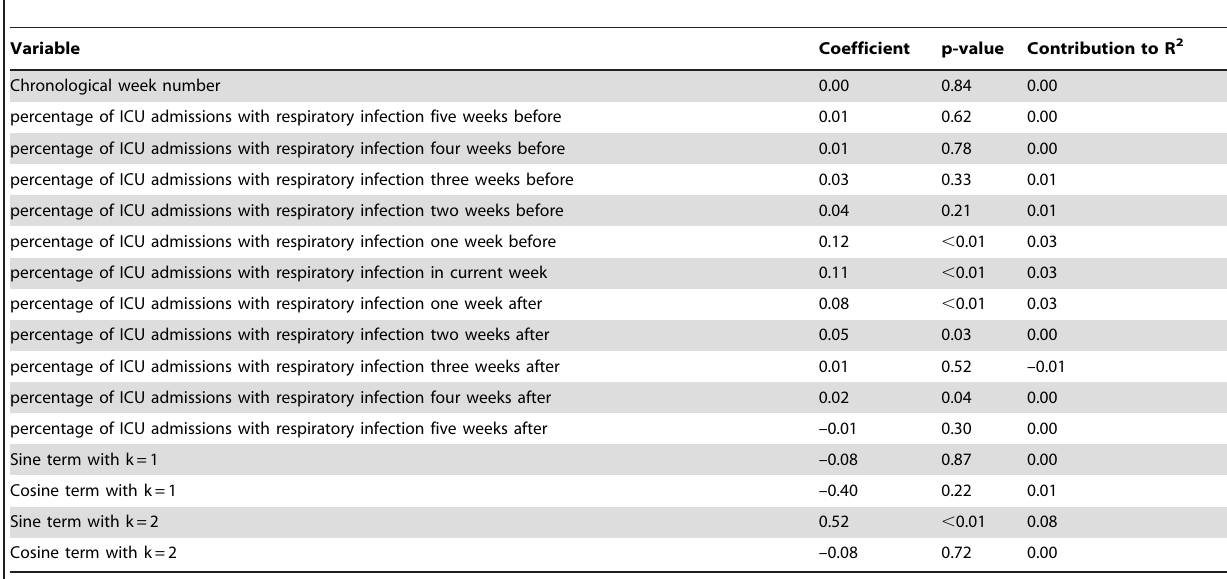
Table 2. GEE additive Poisson regression analysis for assessing the relation between the weekly incidence of Influenza Like Illness and percentage of medical Intensive Care Unit (ICU) admissions with respiratory